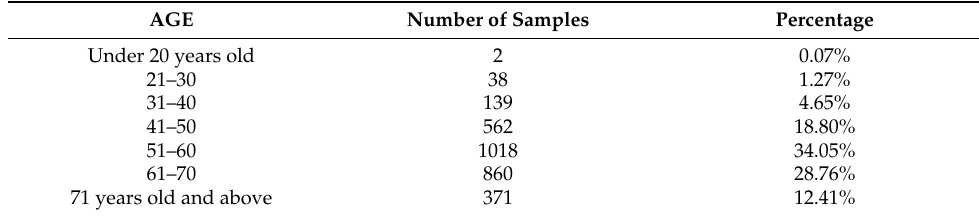
Table 3. Age distribution of the samples.